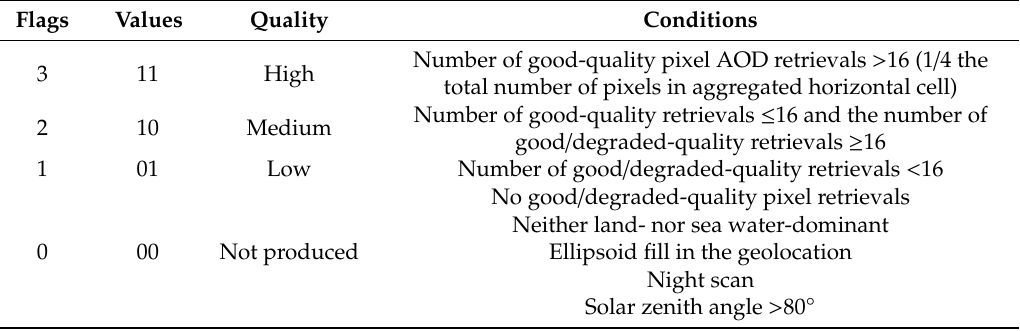
Table 1. Quality flags of Visible Infrared Imaging Radiometer Suite (VIIRS) environment data record (EDR) aerosol optical depth